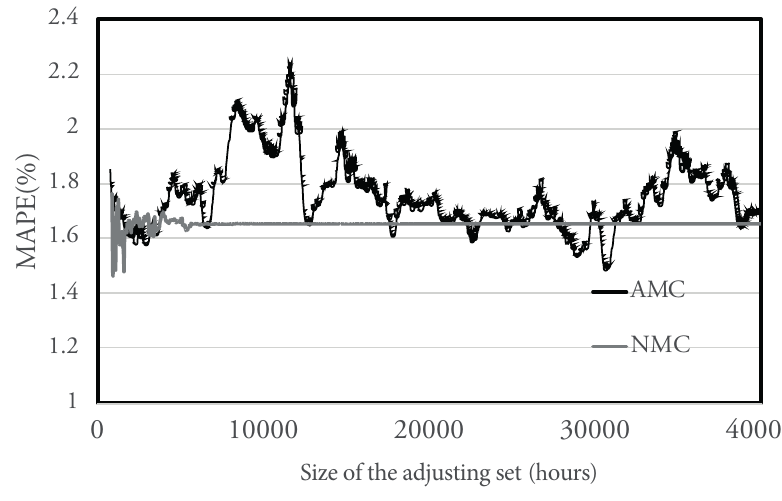
Figure 4. MAPE of the 24-hours ahead forecasts according to the size of the datasets used to obtain the model.